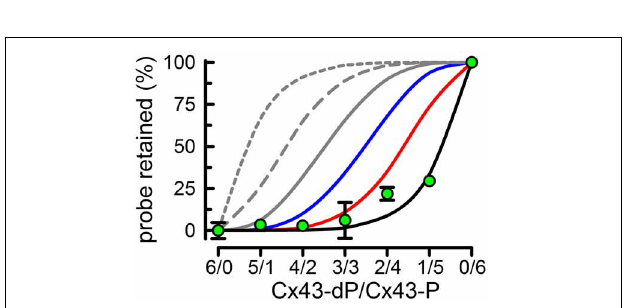
FIGURE 7 | All subunits have to be phosphorylated by PKC to abolish Cx43-HC sucrose permeability. Effects of varying Cx34-dP/Cx43-P average ratios on the % sucrose-permeable proteoliposomes preloaded with radiolabeled sucrose. Data are means ± s.e.m. of 4–7 experiments. Lines represent the expected % (calculated from the binomial distribution) if the number of Cx43-P subunits necessary to render the HC impermeable to sucrose are ≥ 1 (gray, short dash), ≥ 2 (gray, long dash), ≥ 3 (gray, solid), ≥ 4 (blue), ≥ 5 (red), or 6 (black). Modified from Bao et al.,